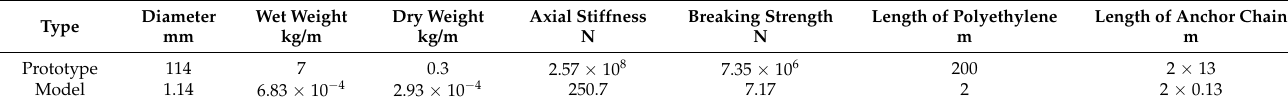
Table 4. Tensioned mooring line parameters.